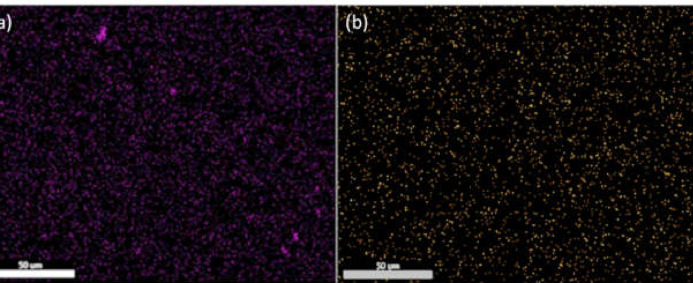
Figure 3. Distribution of Mn and S element in the PVDF/ZnS:Mn thin films. ( a ) Mn element; ( b ) S element.